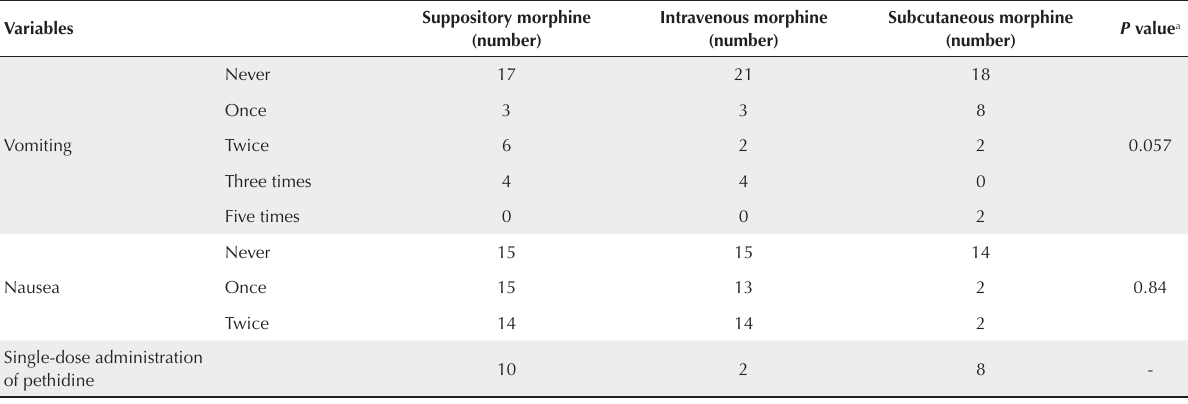
Table 3. Comparison of the frequency of nausea and vomiting and single-dose administration of pethidine among the studied groups